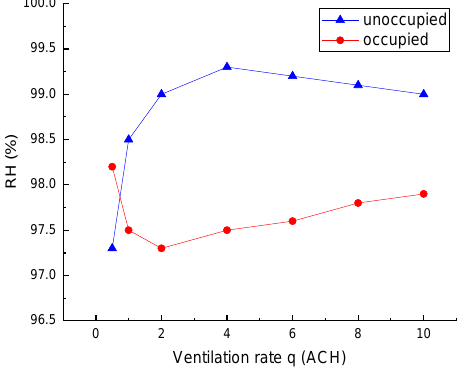
Figure 8. The highest indoor air RH with different ventilation rates.